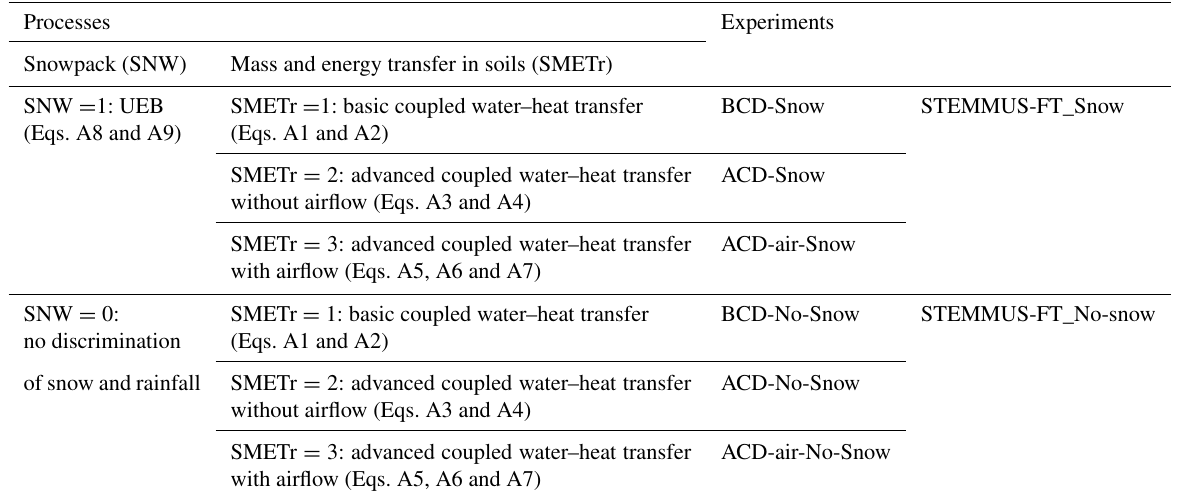
Table 3. Numerical experiments with various mass and energy transfer schemes with and without explicit consideration of snow cover (Eqs. A1–A7 are listed in Appendix A1; Eqs. (A8)–(A9) are listed in Appendix A2). Processes Experiments Snowpack (SNW) Mass and energy transfer in soils (SMETr) BCD-Snow